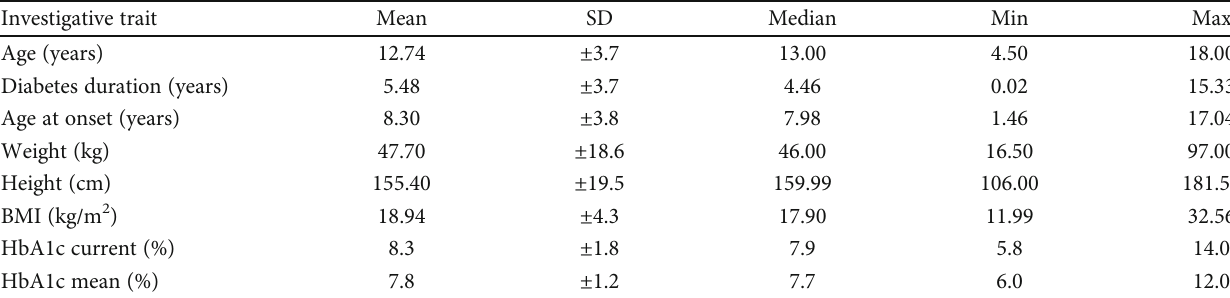
Table 1: The characteristics of the studied